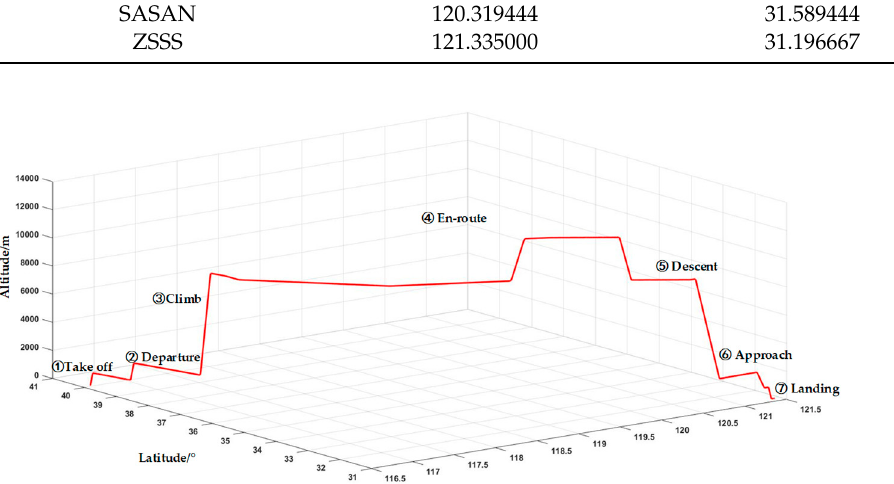
Figure 12. Flight simulation trajectory. Table 1. Simulation track waypoint table.